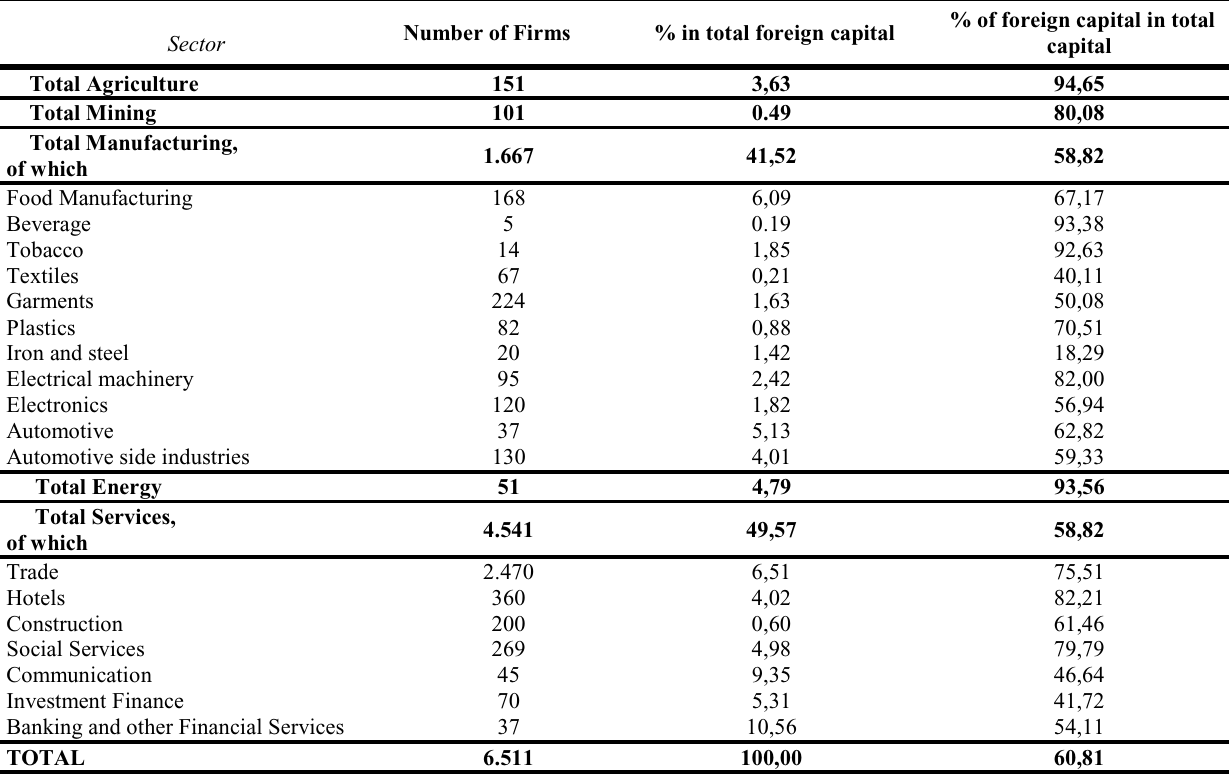
Table 3 . Sectoral distribution of foreign capital companies in Turkey